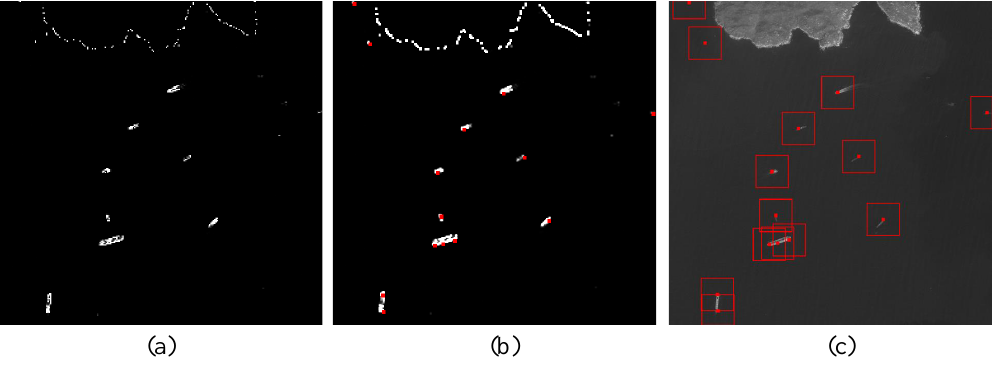
Figure 6. The results of the ship candidate region proposal based on enhanced DWT. ( a ) The enhanced high frequency detail image; ( b ) the centers (red points) of potential ship candidate regions; ( c ) ship candidate region extraction in the panchromatic